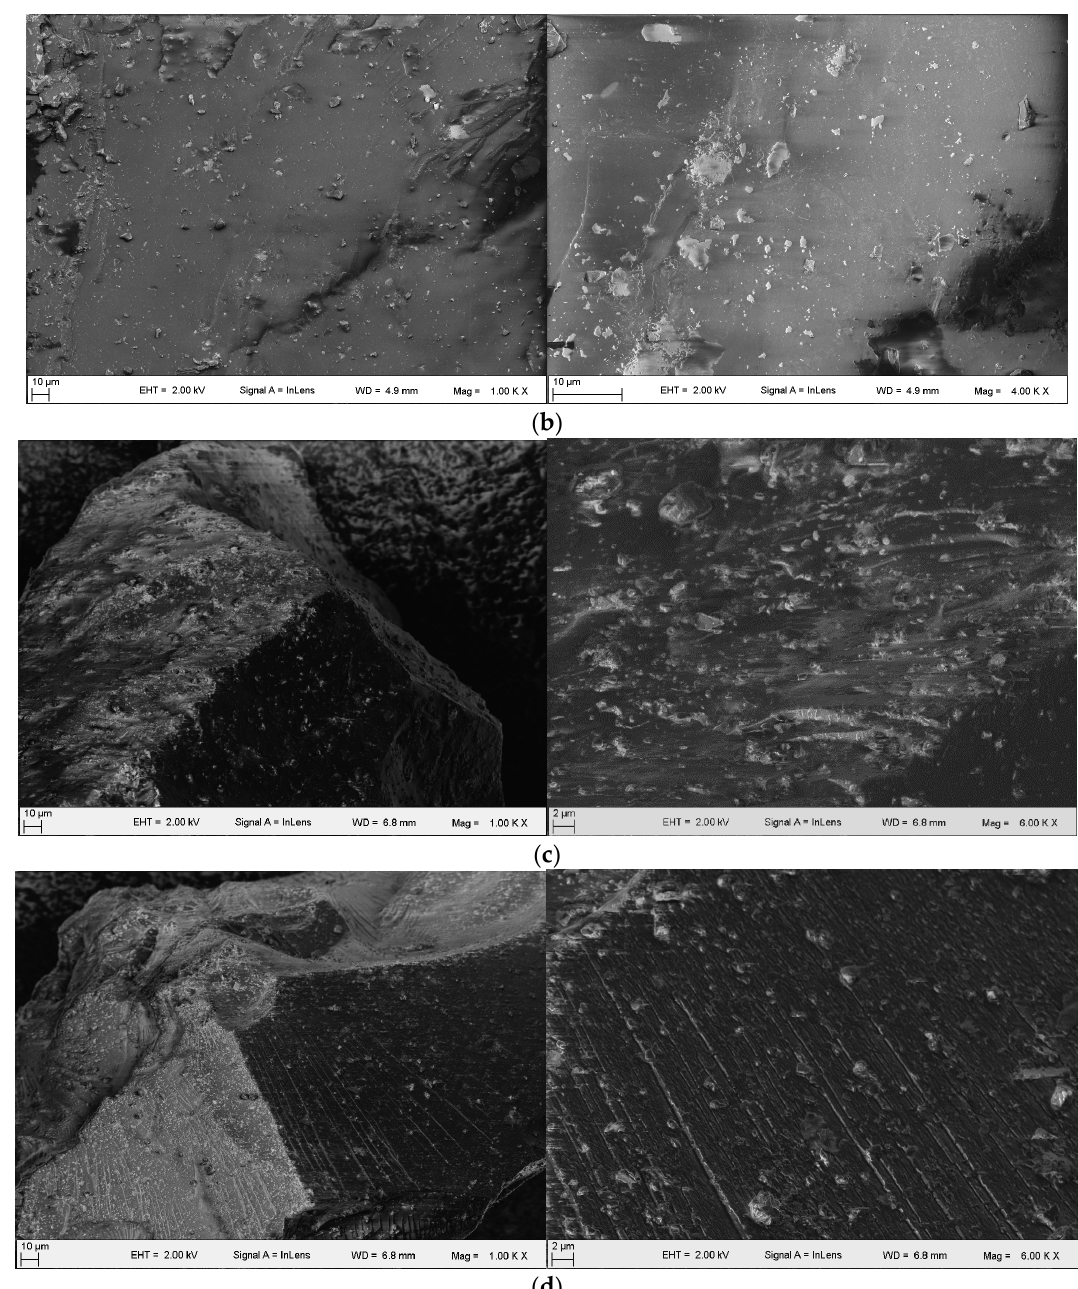
Figure 6. SEM images of the coal samples. ( a ) HY; ( b ) SY; ( c ) XZ; ( d ) DJH.